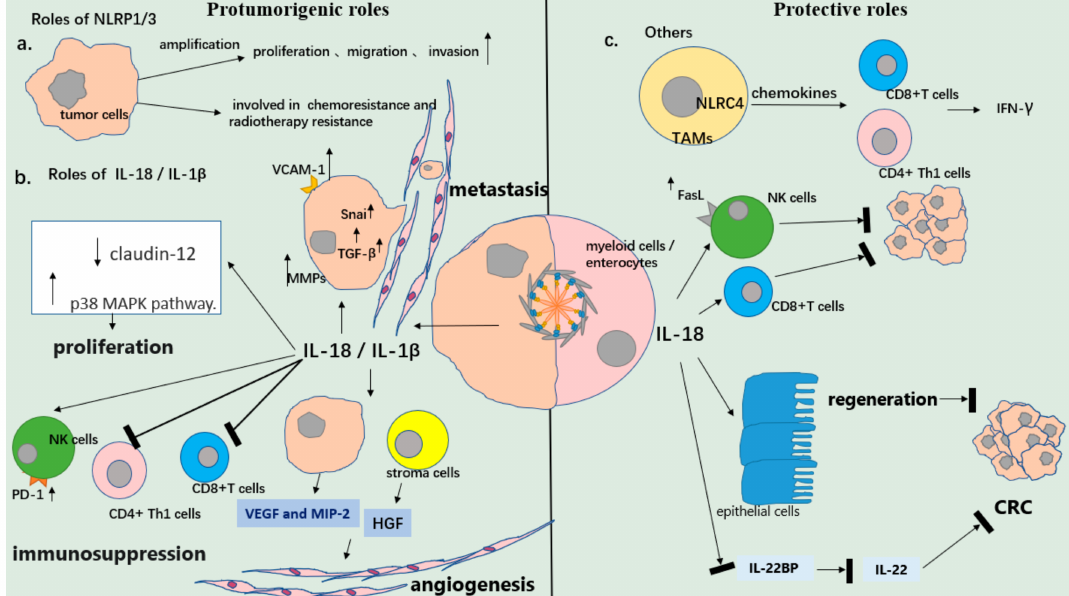
Figure 2. Diverse roles of the inflammasome in cancer. ( a ) NLRP3 mediates the proliferation and invasion of tumor cells. A higher expression of NLRP3 in tumor is associated with the clinical outcomes of patients. ( b ) The release of IL-18 /IL-1 β from tumor cells induces tumor proliferation, immunosuppression, angiogenesis, and metastasis. However, IL-18 from myeloid cells or enterocytes can activate cytolytic immune cells and inhibit the formation of tumors (colorectal cancer) via initiating tissue repair. ( c ) Others. Inflammasomes such as NLRC4 in tumor-associated macrophages (TAMs) can inhibit tumor